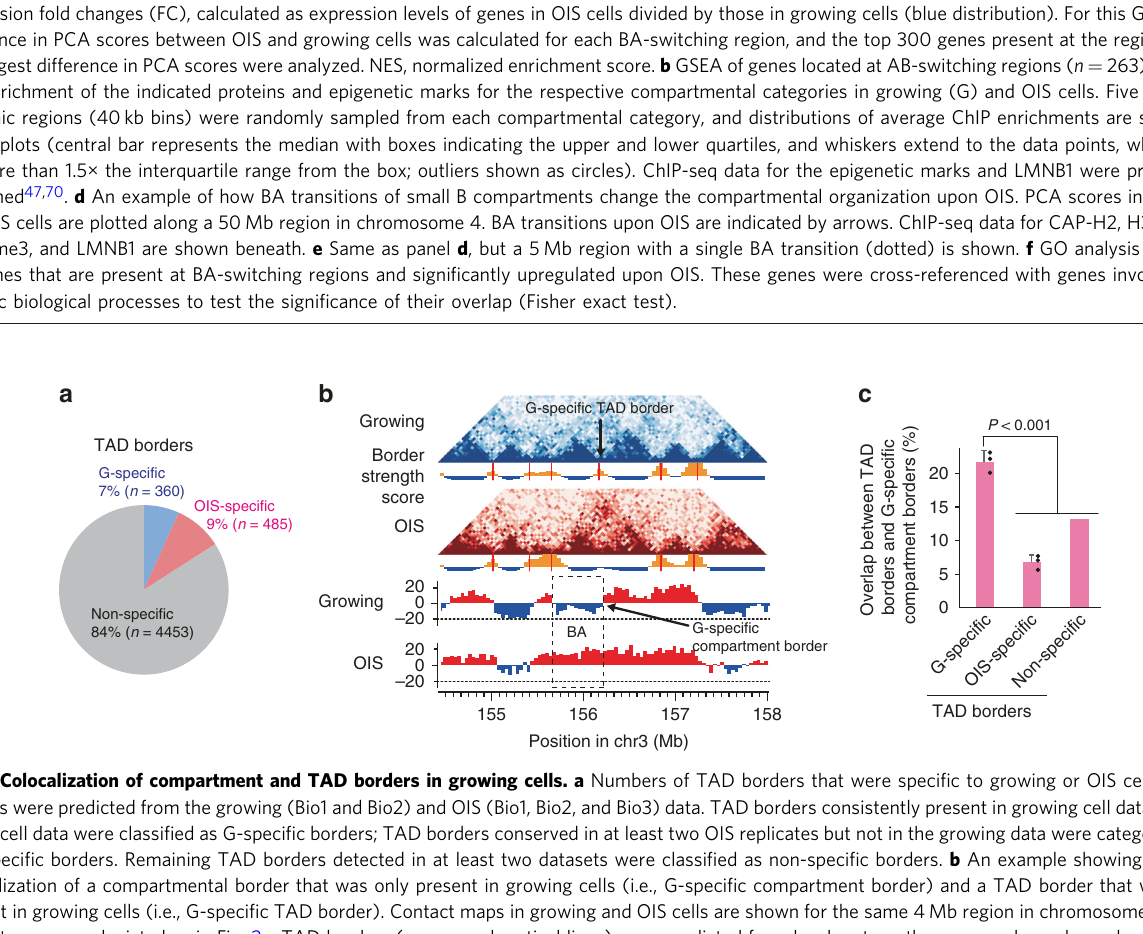
Fig. 5 Colocalization of compartment and TAD borders in growing cells. a Numbers of TAD borders that were speci fi c to growing or OIS cells. TAD borders were predicted from the growing (Bio1 and Bio2) and OIS (Bio1, Bio2, and Bio3) data. TAD borders consistently present in growing cell data but not in OIS cell data were classi fi ed as G-speci fi c borders; TAD borders conserved in at least two OIS replicates but not in the growing data were categorized as OIS-speci fi c borders. Remaining TAD borders detected in at least two datasets were classi fi ed as non-speci fi c borders. b An example showing the colocalization of a compartmental border that was only present in growing cells (i.e., G-speci fi c compartment border) and a TAD border that was only present in growing cells (i.e., G-speci fi c TAD border). Contact maps in growing and OIS cells are shown for the same 4 Mb region in chromosome 3 (top); contact maps are depicted as in Fig. 2a. TAD borders (narrow red vertical lines) were predicted from border strength scores and are shown beneath the maps (Methods). PCA scores in growing and OIS cells are shown at the bottom. c Frequency of overlap between G-speci fi c TAD borders and G-speci fi c compartment borders, as exempli fi ed in panel b . Overlap between different types of TAD borders and G-speci fi c compartment borders was counted. Positions of TAD borders were allowed to shift by ± 1 bin (40 kb) to estimate the overlap with G-speci fi c compartment borders. P -values were calculated by two-sided Student ’ s t -test, using biologically independent samples ( n = 3, error bars represent the (Supplementary Fig. 6b), while the contact map for IMR90 RS Fig. 2e). Differently than for OIS cells, upon RS the sizes of both A cells (Fig. 6a) did not suggest the existence of SAHF. In this and B compartments became signi fi cantly (~1.5×) enlarged, in the regard, we noticed that DAPI foci in IMR90 RS cells were slightly both cell lines; correspondingly, the numbers of A and B com- more diffuse compared to DAPI foci in OIS cells, and only 20% of partments decreased (Supplementary Fig. 6g, h). As the average IMR90 RS cells presented DAPI foci, potentially explaining the size of A compartments increased by approximately the same absence of a SAHF-derived contact pattern in IMR90 RS cells amount (~1.5×) upon RS as upon OIS (Fig. 2e), the enlargement of (Supplementary Fig. 6b). A compartments may be a common senescent feature conserved